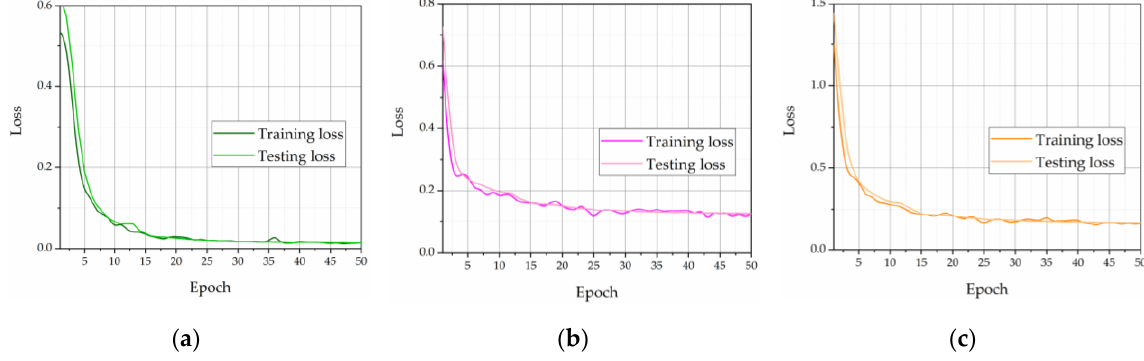
Figure 10. Losses of the M-O SiamRPN with multi-optimization: ( a ) The loss of classification branch; ( b ) The loss of location regression branch; ( c ) The total loss.